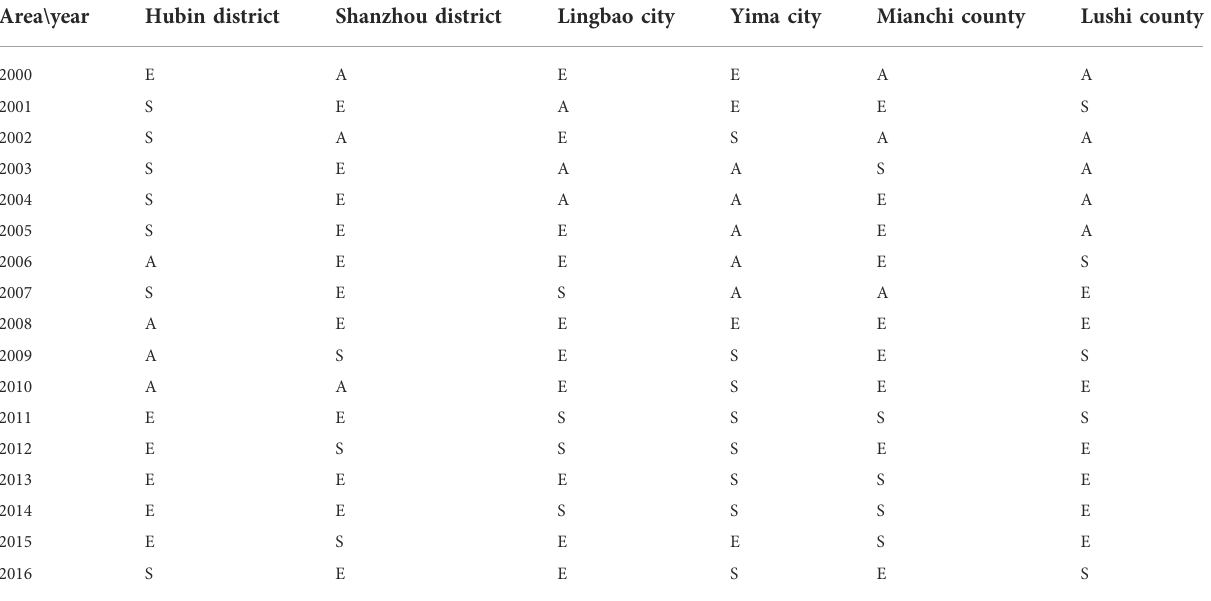
TABLE 6 Changes in dominant types of farmland system vulnerability in districts and counties of Sanmenxia City.